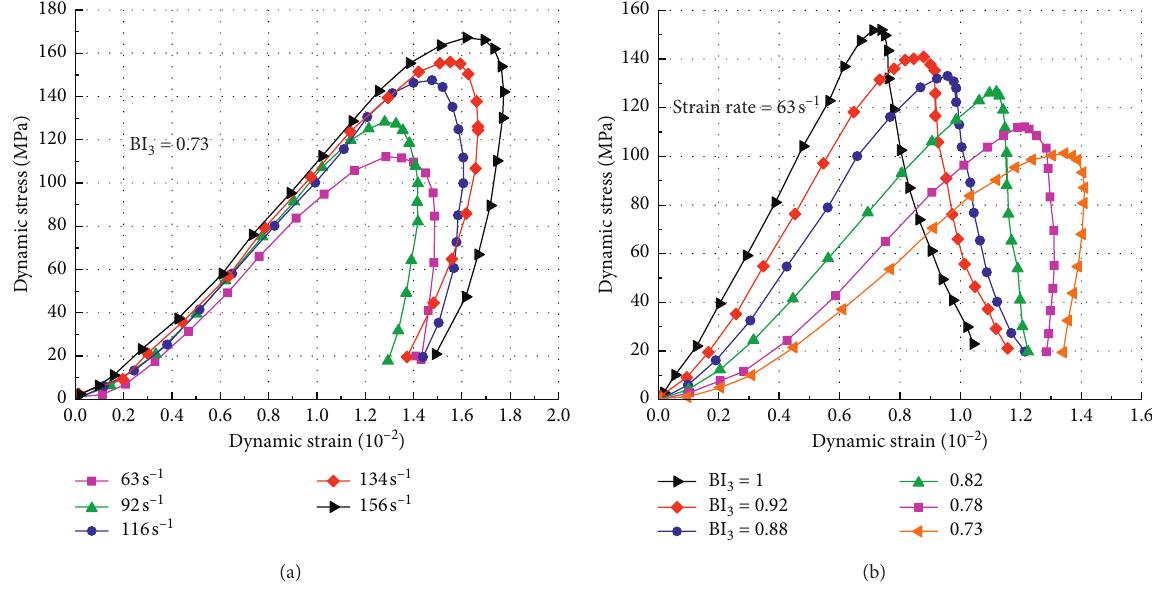
Figure 7: Dynamic stress-strain curves of the samples. (a) At the same brittleness condition. (b) At the same loading strain rate.